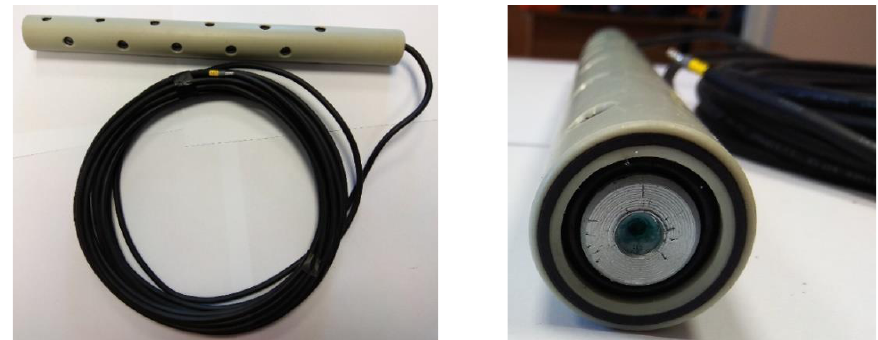
Figure 8. View of a zinc electrode intended for installation within the protection system.